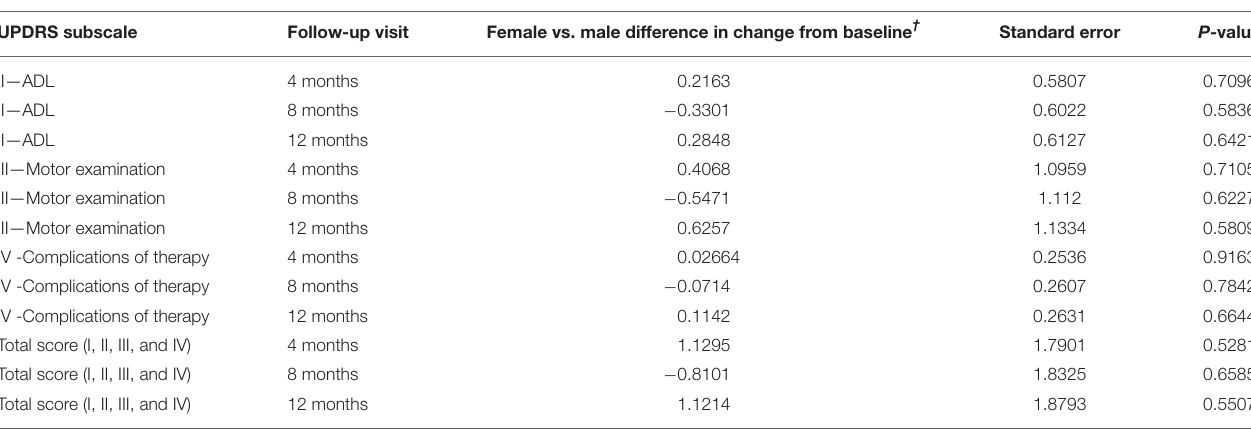
TABLE 2 | UPDRS changes from baseline at each follow-up visit in female vs. male patients. UPDRS subscale Follow-up visit Female vs. male difference in change from baseline † Standard error P -value